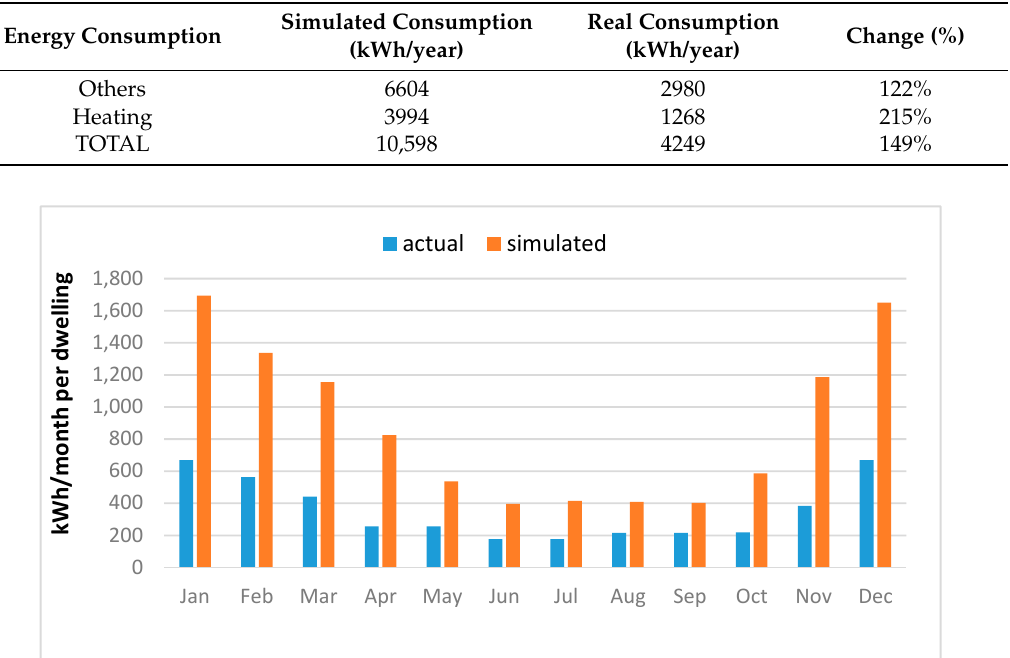
Table 8. Comparison of simulated and actual consumption in a dwelling of building B, in kWh/year.